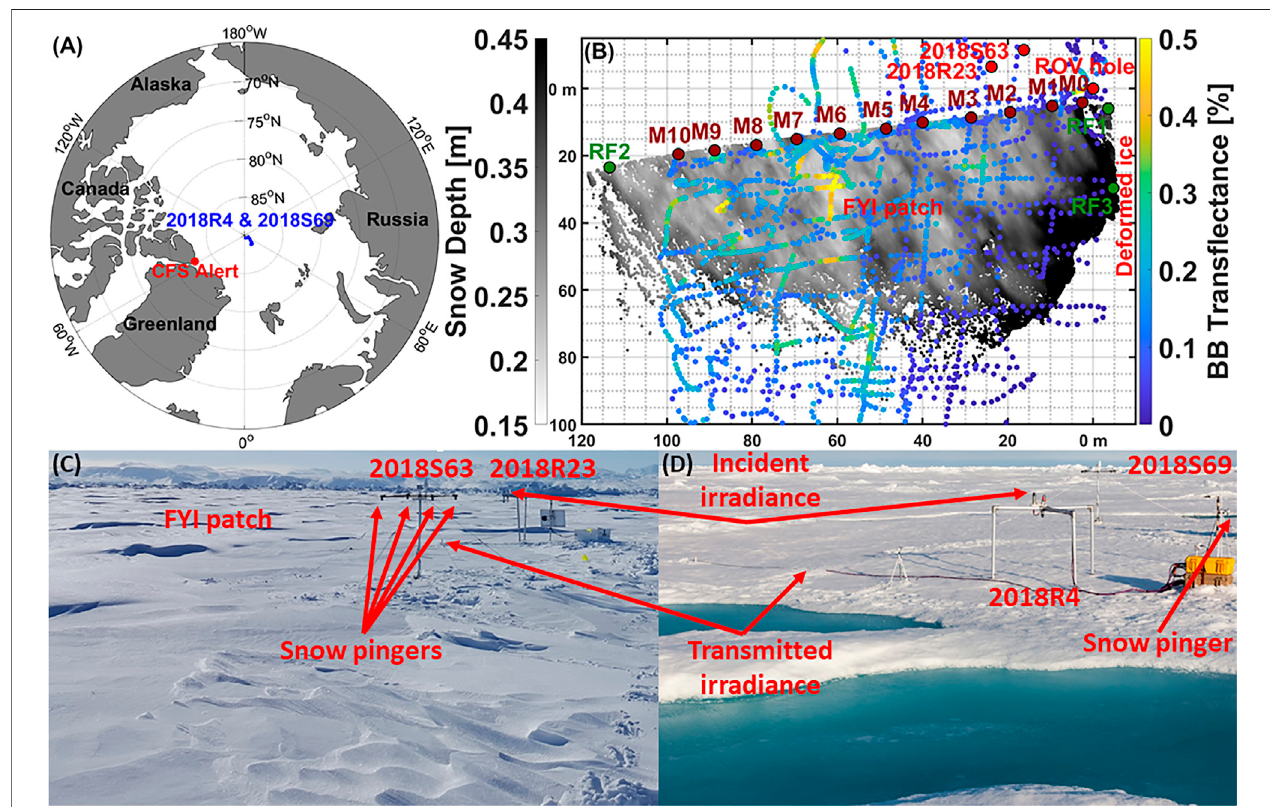
FIGURE1|(A) LocationoftheMAPLI18campaignclosetotheCanadianForces Station(CFS) AlertintheLincoln Seaand thedrift oftheradiationstation 2018R4 and the snow buoy 2018S69 close to the geographic North Pole during the AO18 campaign. (B) Map of the FYI patch during MAPLI18 displaying snow depth in m derivedfromtheterrestrial laserscannerasmeasured on23May(greyscale). Overlaidisthebroadband(BB)trans fl ectancein%(colourscale)measuredbytheROVon 22 May. Circles indicate the marker locations M0 to M10 (dark red), the access hole of the ROV in the ice (red), and the locations of the radiation station 2018R23 and the Snow Buoy 2018S63 (red). RF1-3 (green circles) are the re fl ectors used to process the laser scanner data. (C) Radiation station 2018R23 and Snow Buoy 2018S63 as of May 5, 2018. (D) Radiation station 2018R4 and Snow Buoy 2018S69 as of August 20, 2018 (photo: Mario Hoppmann, AWI).